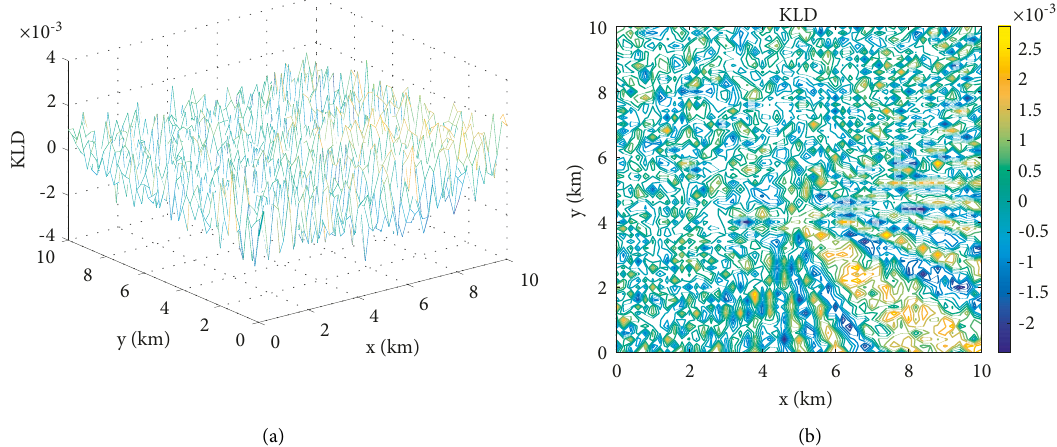
Figure 9: The simulation results when the target’s RCS is − 40dBsm. (a) The 3D KLD information distance distribution. (b) The 2D KLD information distance distribution.